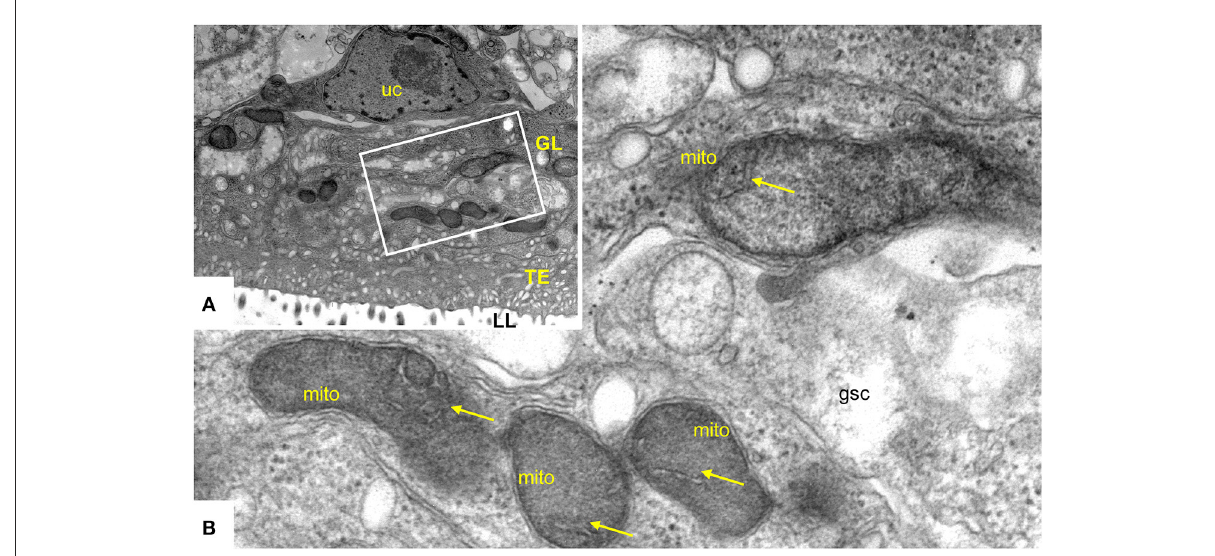
FIGURE7 Transmission electron microscopy (TEM) of E. multilocularis metacestodes treated with 2 µ M ELQ-400 under anaerobic conditions. (A) Is a lower magnification view, the boxed area is enlarged in (B) . LL, laminated layer; TE, tegument; GL, germinal layer; uc, undifferentiated cell; gsc, glyocogen storage cell; mito, mitochondrion. Arrows point toward mitochondrial cristae which are clearly visible. Bars in (A) = 2.4 µ m; (B) = 0.25 µ